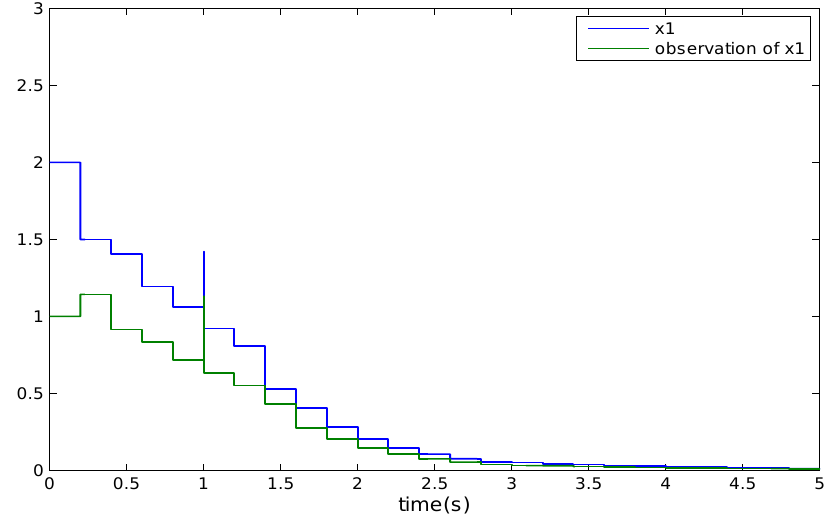
Fig. 1. The state trajectory of x 1 and state observation trajectory ˆ x 1 .